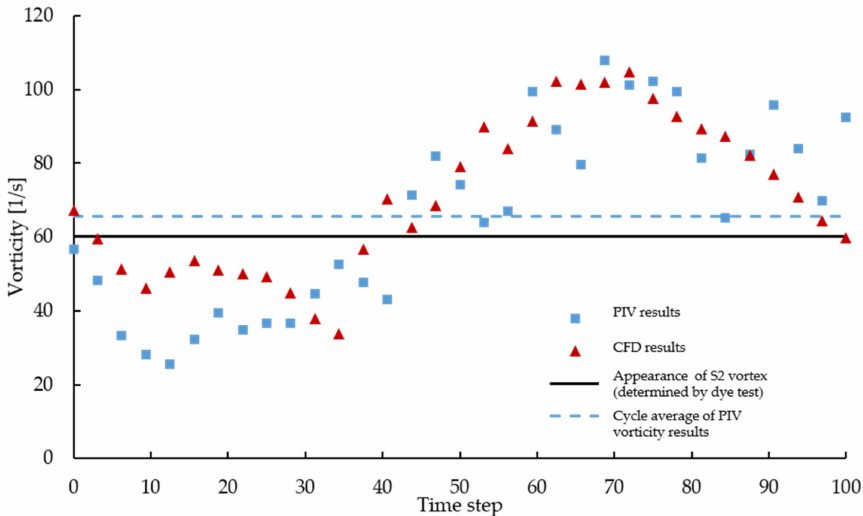
Figure 10. Vorticity time series data at Type 2 subsurface vortex